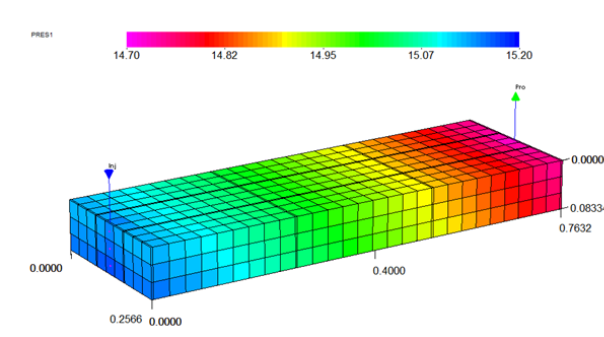
Figure 9: The computational domain and pressure distribution re-